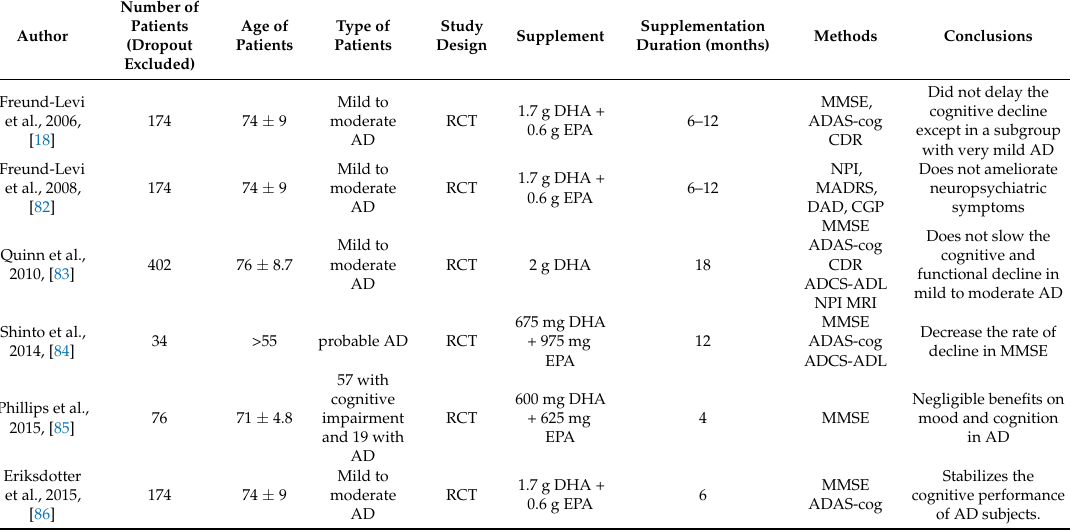
Table 2. Selected clinical trials assessing the impact of omega-3 FAs supplementation in AD patients.